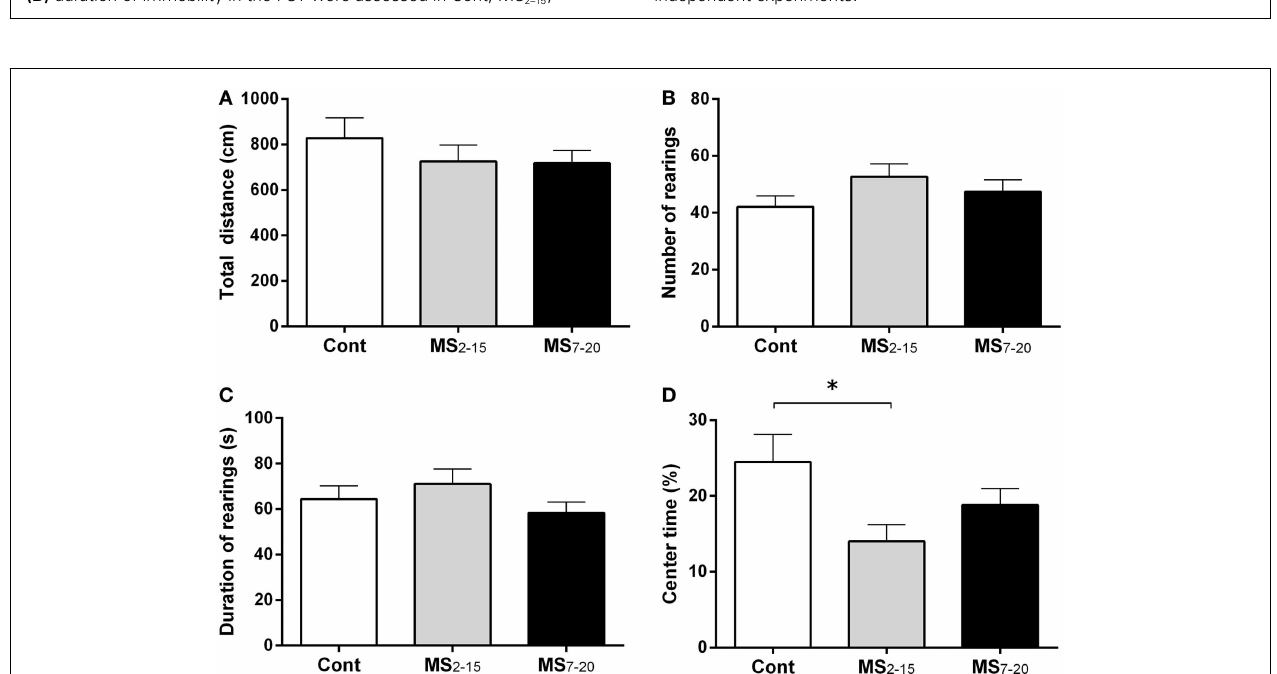
FIGURE 1 | Early maternal separation (MS 2–15 ) induced depressive-like behavior . (A) Latency to first immobility and (B) duration of immobility in the FST were assessed in Cont, MS 2–15 ,